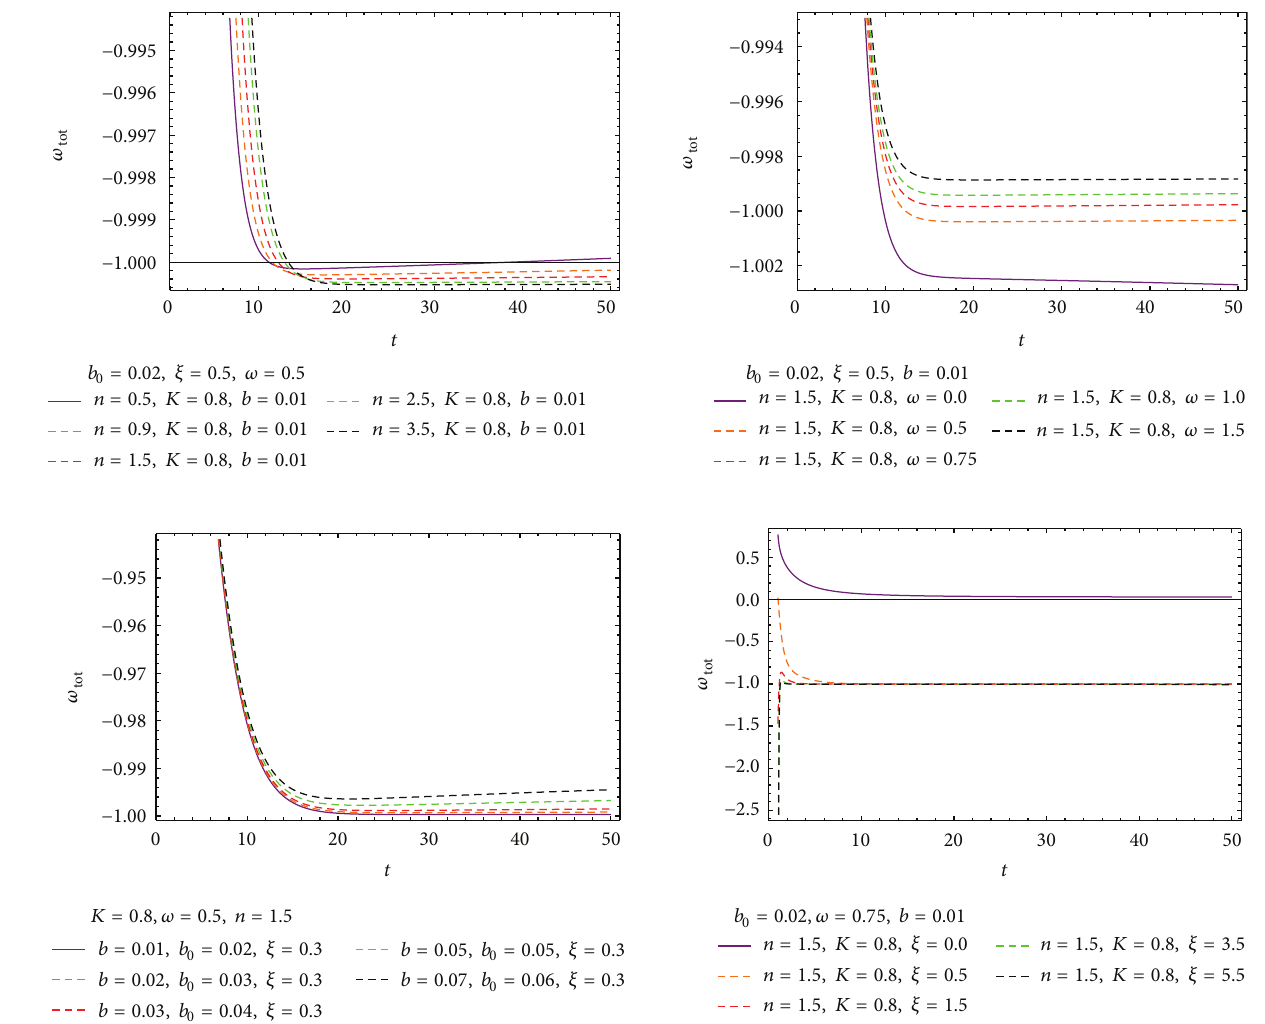
Figure 5: Behavior of EoS parameter 𝜔